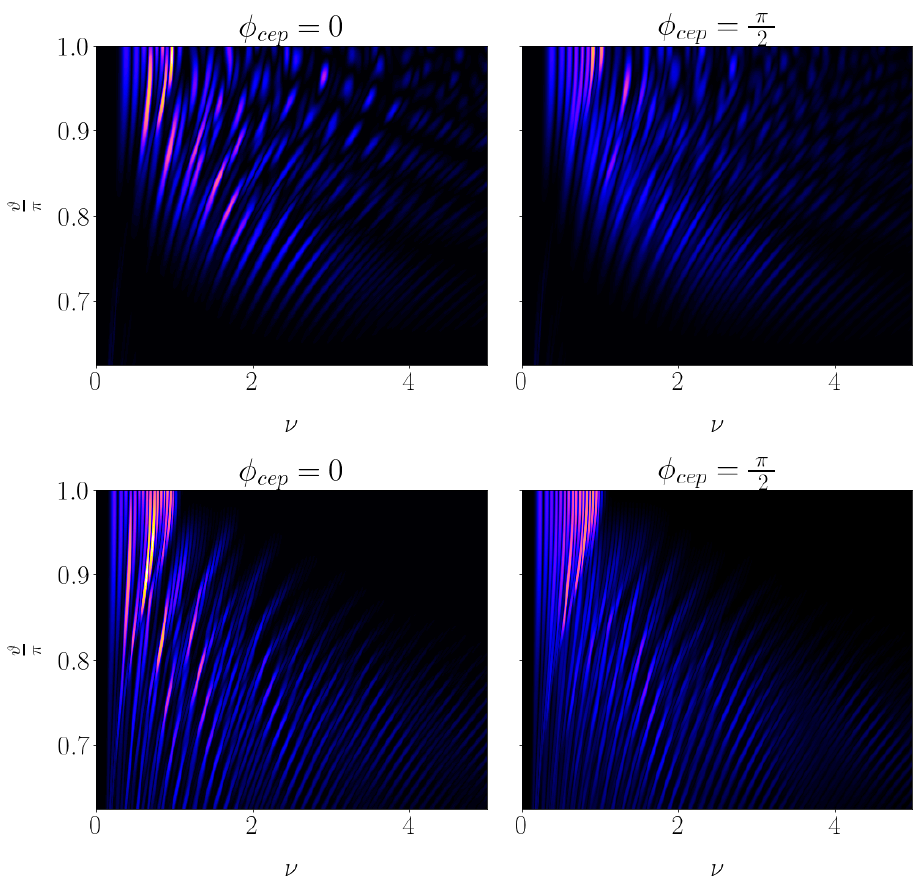
Figure 4. Angular distribution of the spectrum for linear (top two graphs) and circular (bottom two graphs) polarization for a 0 = 2, N c = 5 and γ = 2. The emission cone is relatively large since the energy of the electron is low. The effect of φ cep is clearly visible in the off-axis radiation. Increasing the energy of the electron leads to similar plots as the range of the observation angle ( π and the emitted frequency ( ν = ω